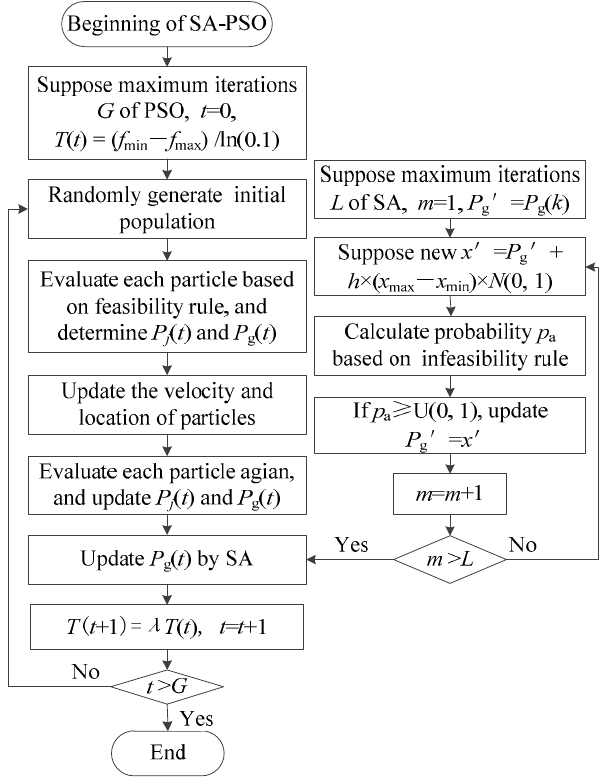
Figure 3. Schematic diagram of simulated annealing–particle swarm optimization (SA-PSO).